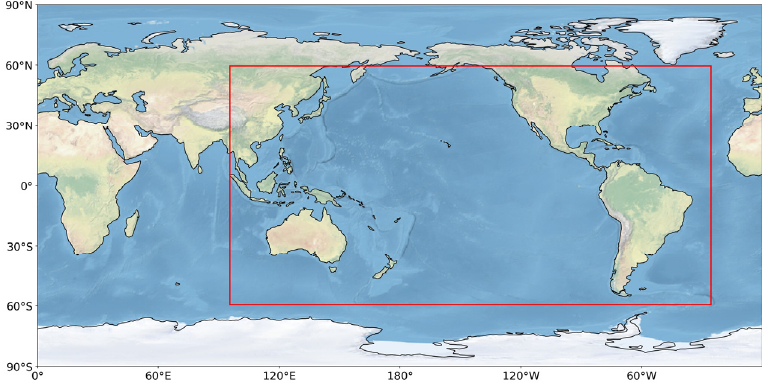
Figure 1. Selected study